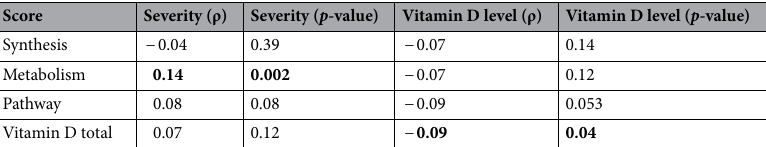
Table 1. PRSs correlation with COVID-19 disease severity and vitamin D level (Spearman correlation). The bold means that the p -value is below 0.05 which is the standard cut-off to be considered statistically significant. The significance level for a study is chosen before data collection and is typically set to 5%.